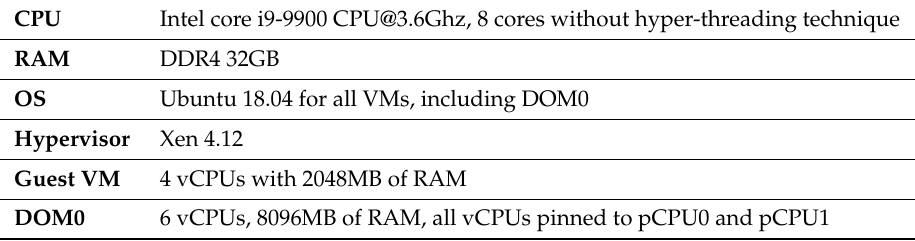
Table 1. Experiment